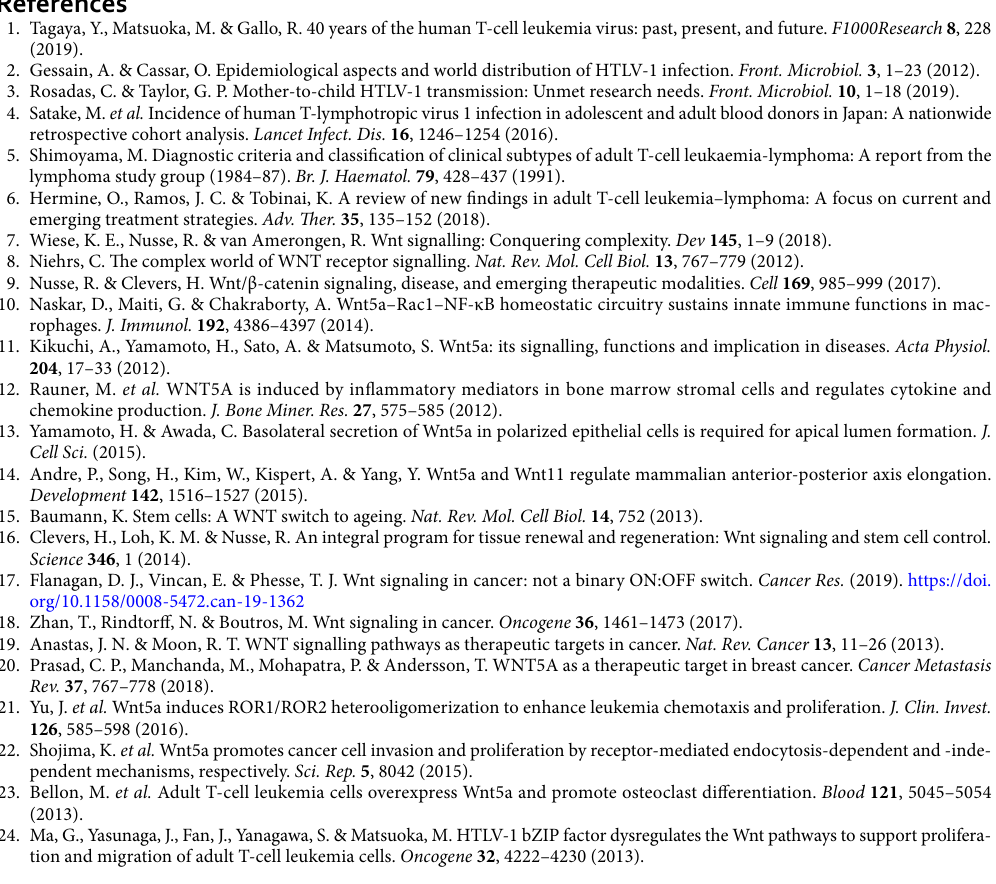
Figure 7. The ΔC-Wnt5a induces strong chemotaxis to CXCL12 and support cell growth. ( A ) The upper panels show the expression of CXCR4 in Jurkat, CEM, TL-Om1, and MT-1 cells measured by flowcytometry. The lower graphs show the relative migration rates toward CXCL12 in Jurkat, CEM, TL-Om1, and MT-1 cells incubated in the medium containing the WT-Wnt5a or the ΔC-Wnt5a (n = 6, mean ± SD, * P < 0.05; ** P < 0.01; *** P < 0.001). Recombinant human Wnt5a (rWnt5a) was added at 100 ng/mL to the medium as a positive control, which induced significantly higher migration rates compared with the negative controls (medium only) in all tested cell lines. The WT-Wnt5a did not stimulate the cellular chemotaxis to CXCL12 except for MT-1. The ΔC-Wnt5a significantly enhanced the chemotaxis to CXCL12 in all cell lines to the same extent compared with the rWnt5a. The treatment with a CXCR4 antagonist (CXCR4i) abolished the cellular migration to CXCL12 in all cell lines. Thus, CXCL12/CXCR4 chemotaxis played a major role in the cellular migration observed in these assays. ( B ) The cell viability assays were conducted in Jurkat and TL-Om1 cells cultured in the medium containing the WT-Wnt5a or the ΔC-Wnt5a. The relative viability was significantly elevated in the both cell lines, which were cultured in the medium containing the ΔC-Wnt5a compared with the cells cultured in mock medium (n = 6, mean ± SD, * P < 0.05; *** P < 0.001). The relative cell viability was significantly elevated only in TL-Om1 cells, which were cultured in the medium containing the WT-Wnt5a (n = 6, mean ± SD, * P < 0.05). ( C ) Summary of this study. We demonstrated that both FoxM1 and c-Myb transactivate Wnt5a expression. Since FoxM1 and c-Myb transactivate each other, elevated levels of FoxM1 and c-Myb in ATL cells synergistically enhance the Wnt5a expression. Such feed-forward molecular mechanism may cause the drastic overexpression of Wnt5a in acute-type ATL cells. Moreover, in acute-type ATL cells, the Wnt5a level is not only elevated, but also a mutant, yet functional Wnt5a, the ΔC-Wnt5a, is overexpressed. Overexpression of the ΔC-Wnt5a may accelerate the dysregulation in the Wnt5a pathway, which may be responsible for malignant phenotypes of acute-type ATL cells, such as uncontrollable cell proliferation, migration, and invasion. Statistical analysis. The statistical difference between experimental groups was evaluated by Student T -test throughout this study. Statistical significance is indicated by astariscs (*p < 0.05, **p < 0.01, and ***p < 0.001). The number of the samples (n) in each experimental group is indicated in the figure